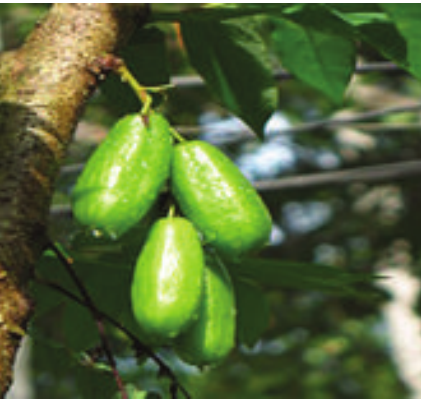
Figure 2: Calcium oxalate crystals in urine in high power